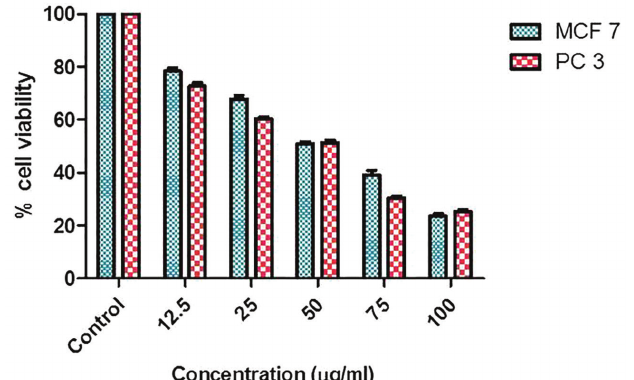
FIGURE 8 - In vitro cytotoxicity assay of different concentrations of AgNPs against MCF 7 and PC 3 cells, expressed in percentage viable